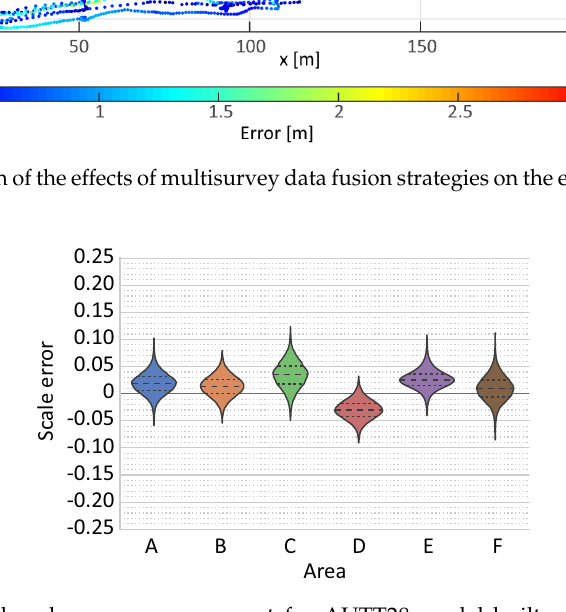
Figure 28. Estimated scale errors per segment for AUTT28 model built with Global SfM with multiobjective BA navigation fusion without an additional offset